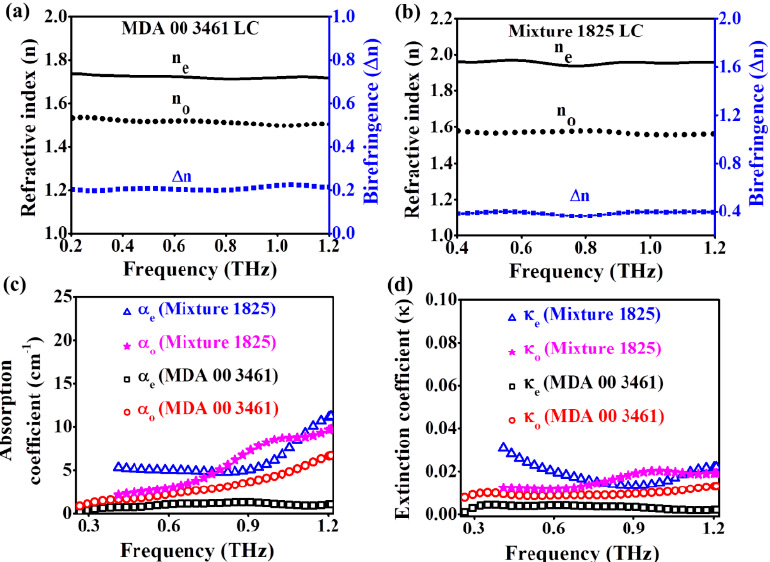
Figure 4. THz optical constants n e , n o , and ∆ n for ( a ) MDA-00-3461 and ( b) Mixture 1825 LC. The ( c ) absorption ( α ) and ( d ) extinction ( κ ) coefficients represent both types of LC molecules.